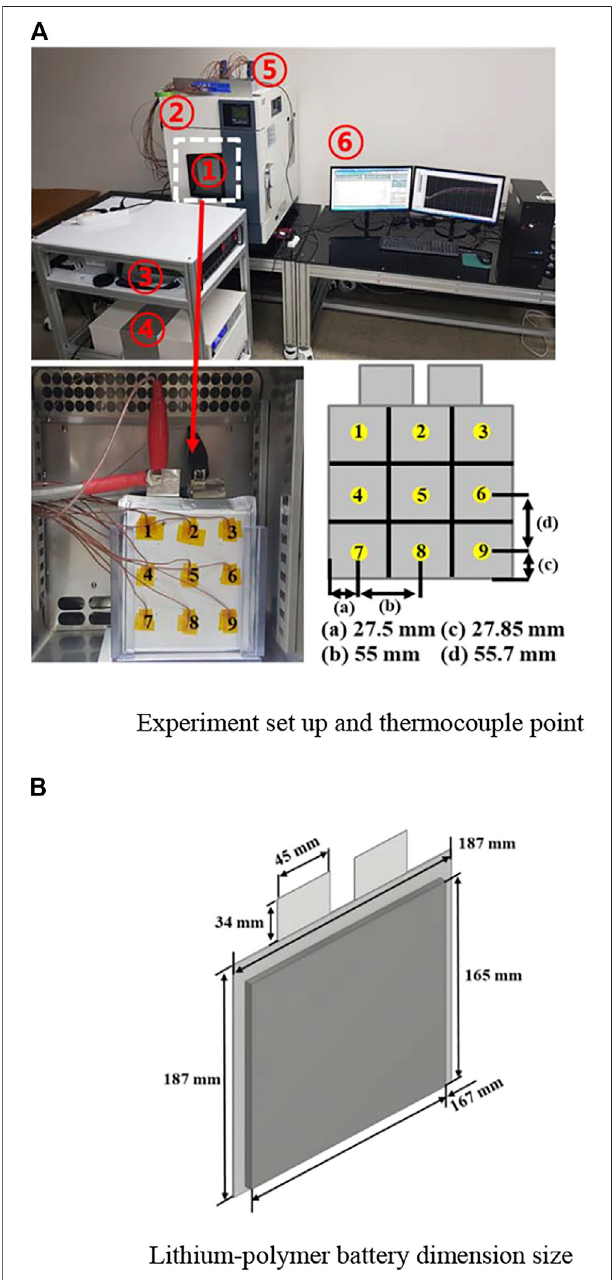
FIGURE 2 | Con fi guration of experimental equipment and lithium- polymer battery. (A) Experiment set up and thermocouple point, (B) Lithium-polymer battery dimension size.